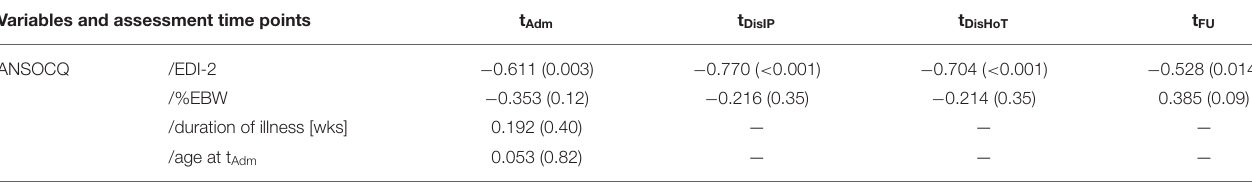
TABLE 3 | Correlation of the ANSOCQ sum scores at all four measuring times with illness severity (ED-specific sum scores of EDI-2 and %EBW) and baseline characteristics. Variables and assessment time